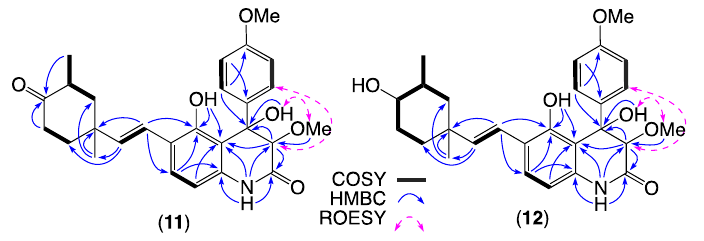
Figure 7. Selected 2D NMR (CDCl 3 ) correlations for 11 and 12 .